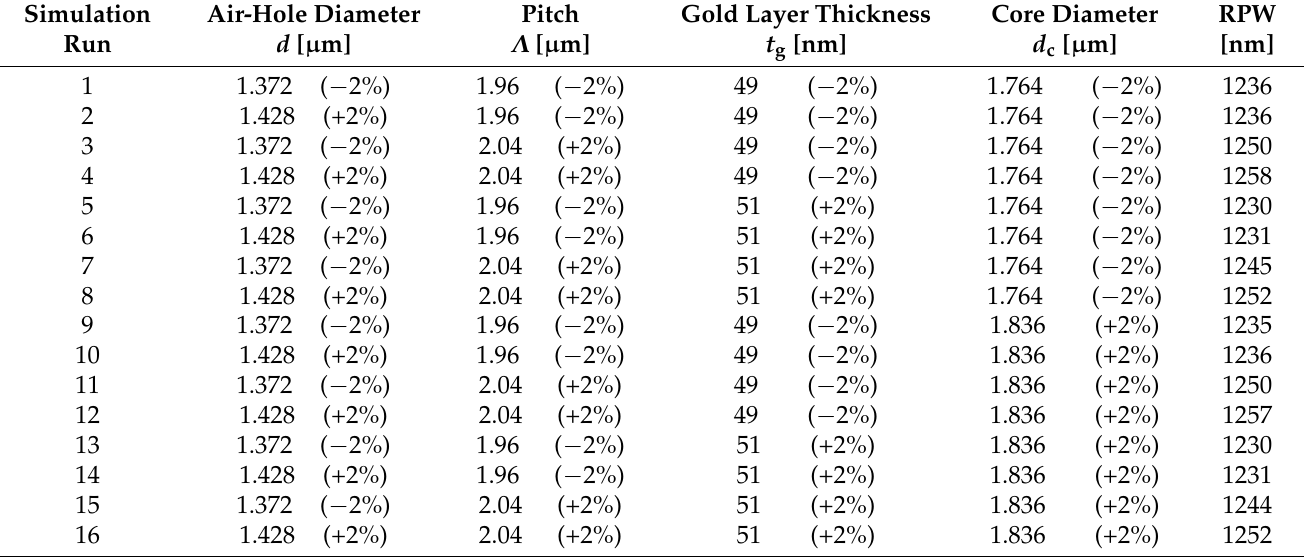
Table 3. FEM Simulations for Two-Level 4-Parameter ( ± 2% variations) Factorial Analysis. Simulation